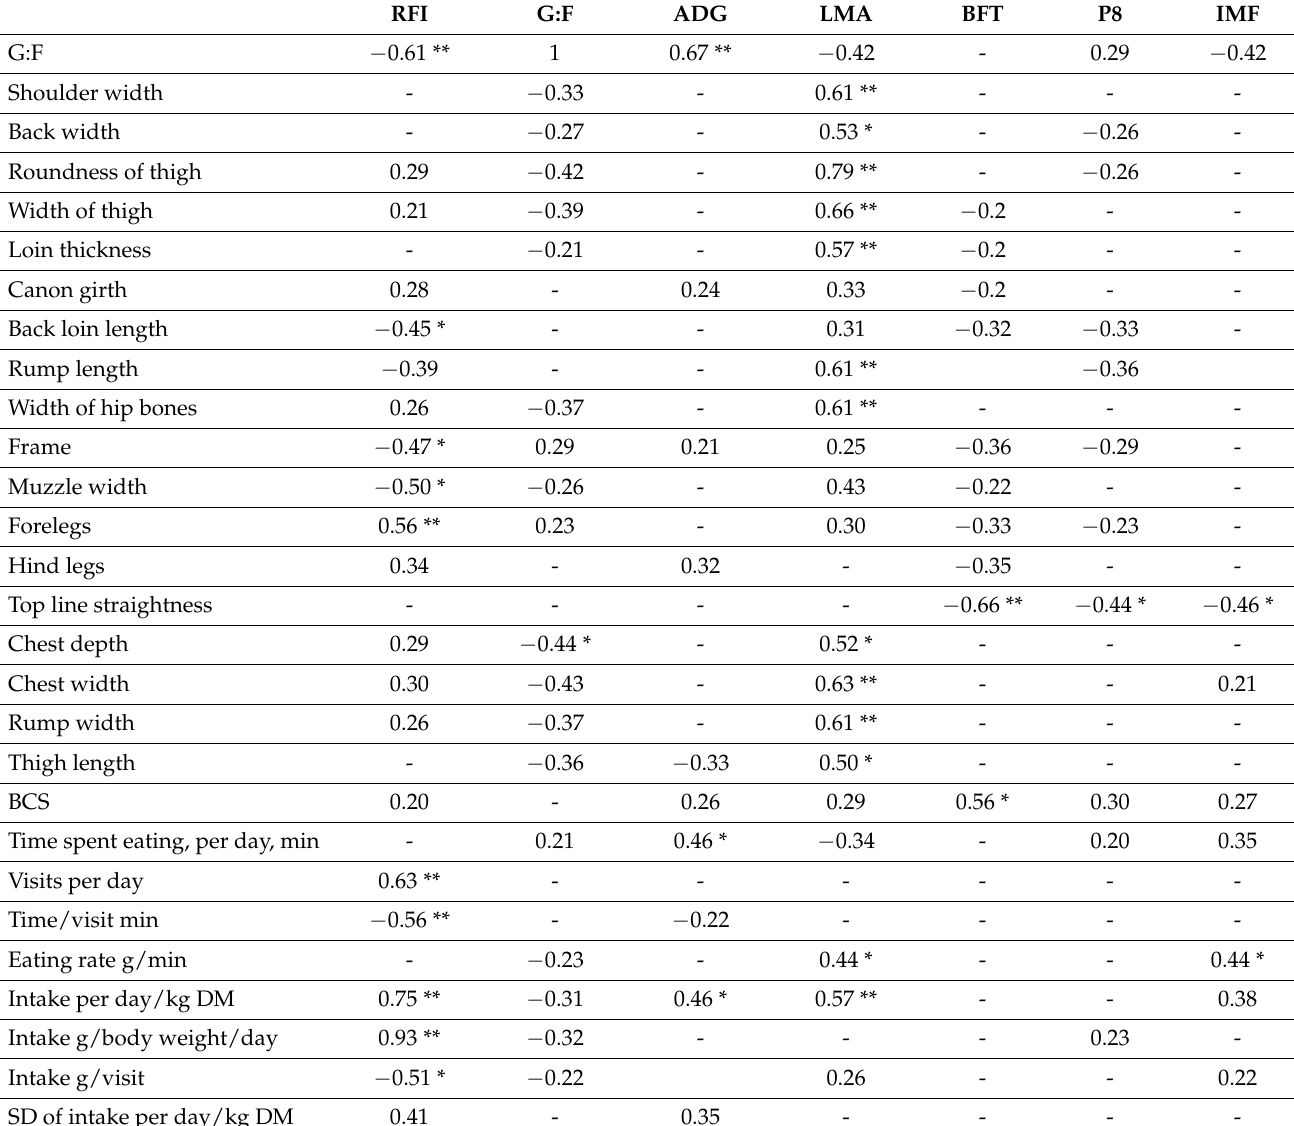
Table 5. Pearson correlation coefficients for pair-wise associations between performance traits, conformation score, and feeding behavior. RFI: residual feed intake; G:F: feed conversion ratio;